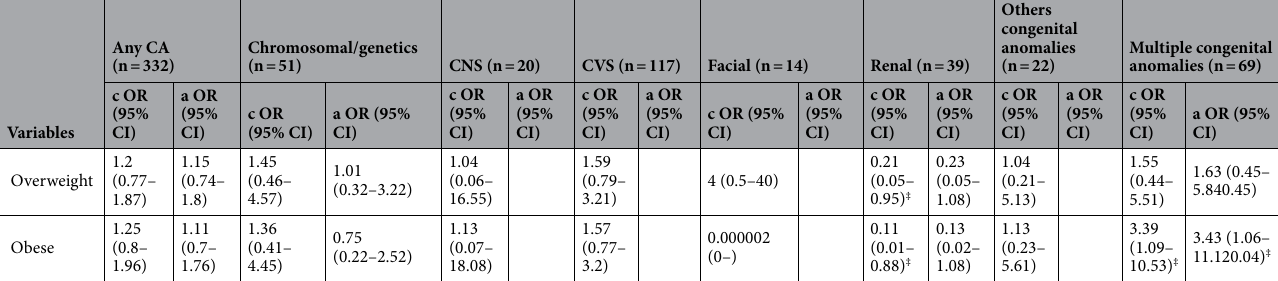
Table 2. Risk factors associated with the occurrence of congenital anomalies including univariate regression analysis (crude odds ratio: cOR) and multiple regression analysis (adjusted odds ratio: aOR) adjusting for the significant factors from the univariate analysis. CNS central nervous system; CVS cardiovascular system; others: gastrointestinal, respiratory, urogenital, and skeletal; multiple: two or more anomalies; GDM gestational diabetes mellitus; PGDM pregestational diabetes mellitus. *p < 0.001; † p < 0.01; ‡ p <